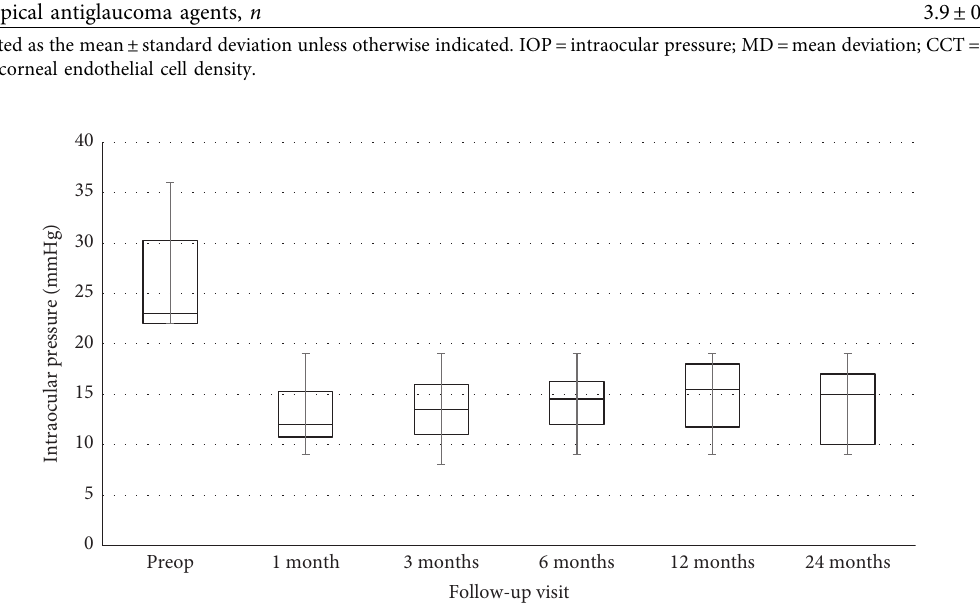
Figure 1: Box-and-whisker plot of the mean intraocular pressure before and after surgery. The horizontal line within each box denotes the median value; the boxes extend from the 25 th to the 75 th percentiles of each group’s distribution of values; the vertical lines denote adjacent values (i.e., the most extreme values within the 1.5 interquartile range of the 25 th and 75 th percentiles of each group). Table 2: Comparison of the mean MD, ECD, and number of topical antiglaucoma